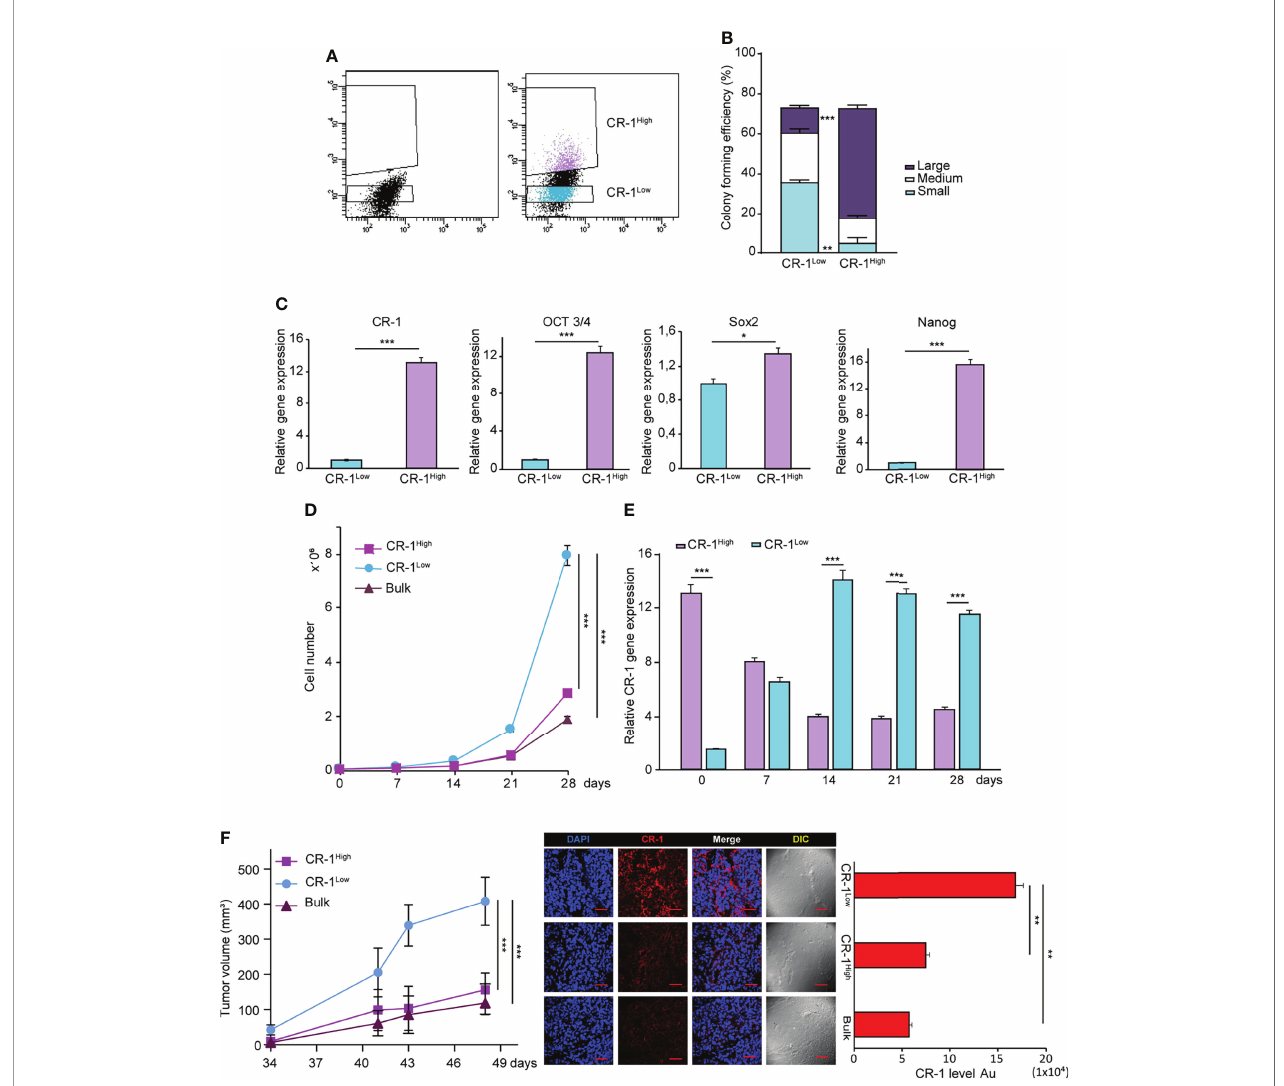
FIGURE 3 | NSCLC subpopulations expressing high or low CRIPTO (CR-1) levels are interconvertible in vitro and in vivo . (A) FACS-based separation of CRIPTO high and CRIPTO low subpopulations of AC1 spheroid cultures. (B) Self-renewal capacity of sorted CRIPTO high and CRIPTO low AC1 spheroid cells, evaluated as colony formation in semisolid culture and expressed in bottom panels as normalized colony size/percentage over plated cells. (C) qRT-PCR analysis of CRIPTO and stem cell related genes (OCT3/4, SOX2, NANOG) performed on CRIPTO high and CRIPTO low subpopulations of AC1 spheroids. (D) Proliferation curve of CRIPTO high (dark pink square) and CRIPTO low (light blue dot) subpopulations or Bulk (burgundy triangle) cultures of AC1 spheroids, starting at day 0 (after sorting) and monitored at the indicated times. (E) qRT-PCR analysis of CRIPTO high (light purple histogram) and CRIPTO low (light blue histogram) subpopulations at the indicated times starting at day 0 after sorting. (F) Left: In vivo growth of tumor xenografts obtained by subcutaneous inoculation of CRIPTO high (dark pink square) and CRIPTO low (light blue dot) subpopulations or Bulk (burgundy triangle) cultures of AC1 spheroids, monitored at the indicated times. Results shown are the mean ± SEM of values obtained using 4 mice per group. *P < 0.05; **P < 0.01, ***P < 0.001. Middle: representative confocal images of CRIPTO (red) staining of CRIPTO high , CRIPTO low and Bulk tumors. 40X magni fi cation, scale bar 50 m m. Right: quanti fi cation of CRIPTO performed on 3 sets composed of 5 fi elds/group. **P<0.01. AU, arbitrary